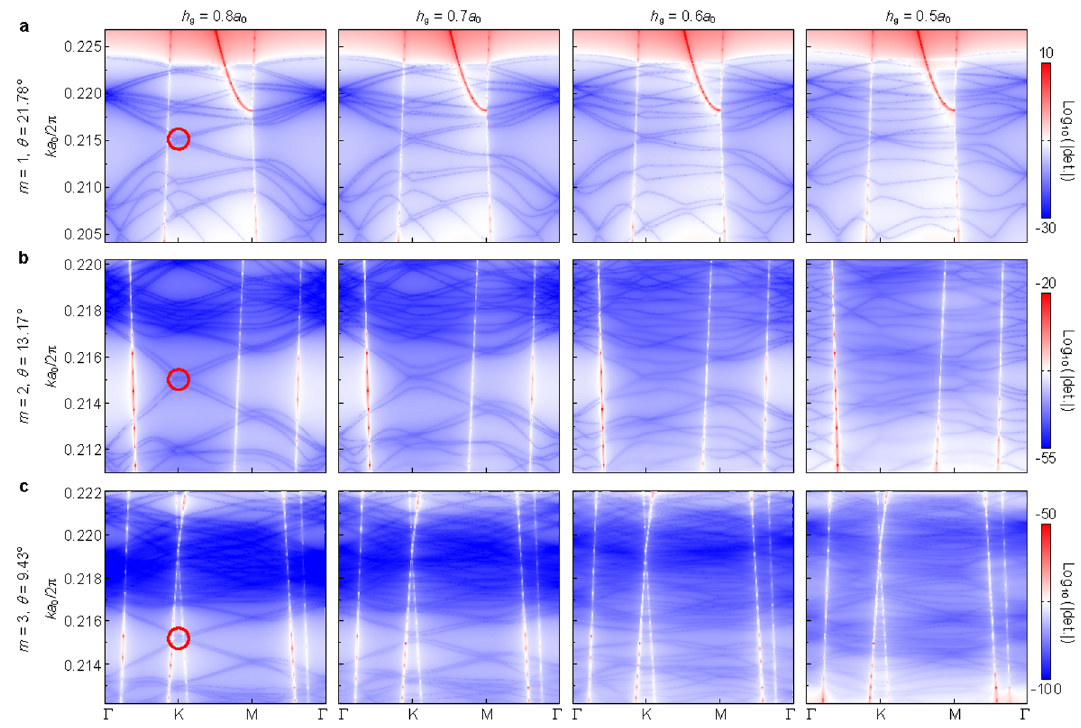
Fig. 2 Dispersion relation of the holey twistsonic medium with different gap separations h g and twist angles. Speci fi cally, we vary the gap from h g = 0.8 a 0 to h g = 0.5 a 0 (four columns) and twist the bilayer according to a m = 1 ( θ = 21.78 ∘ ), b m = 2 ( θ = 13.17 ∘ ), and c m = 3 ( θ = 9.43 ∘ ). The plate thickness is fi xed at h 1 = h 2 = h = 2 a 0 . Red circles mark the regions of the fi eld plots in Fig.